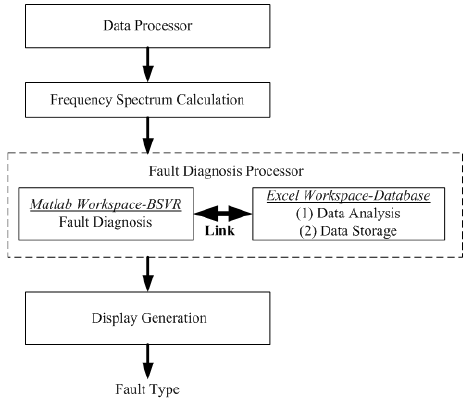
Figure 4. PC ‐ based BGFDS for generator fault detection. Figure 4. PC-based BGFDS for generator fault